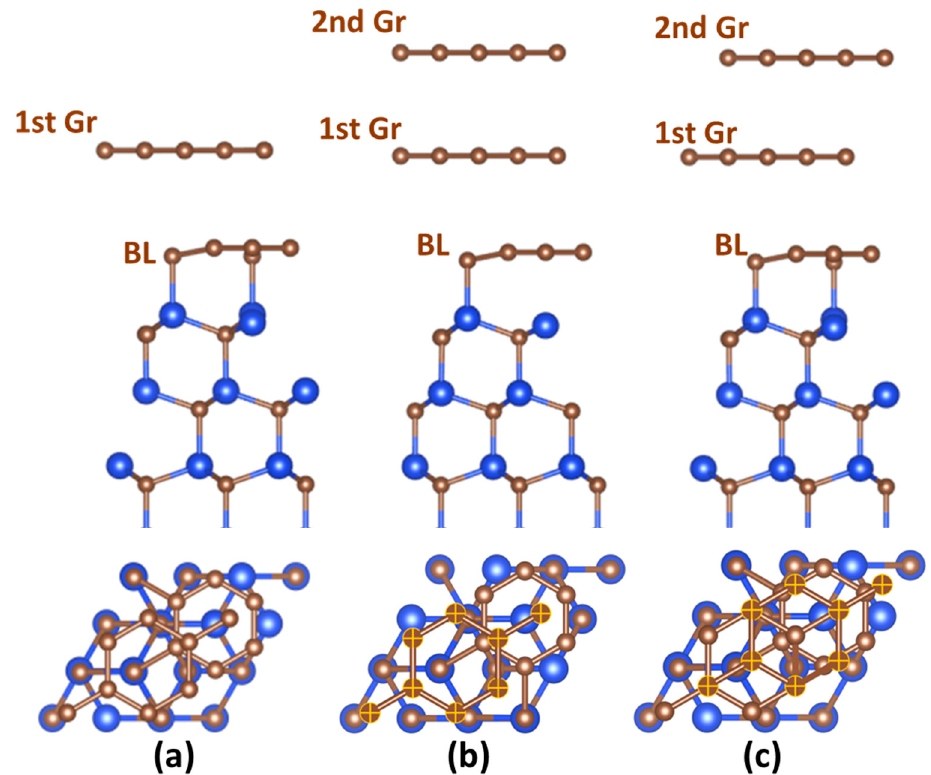
Figure 1. (Side and top views) Optimized structures of MLG/SiC ( a ), AA-BLG/SiC ( b ), and AB- BLG/SiC ( c ) electrodes. BL designates the buffer layer. Blue and brown balls represent silicon and carbon atoms, respectively, while yellow crosses denote the carbon atoms belonging to the second graphene layer. For the sake of convenience, we demonstrate three Si-C bilayers of 4H-SiC layers, although the original structures include nine Si-C bilayers. This is to avoid the substrate thickness effect on lithium adsorption and intercalation.